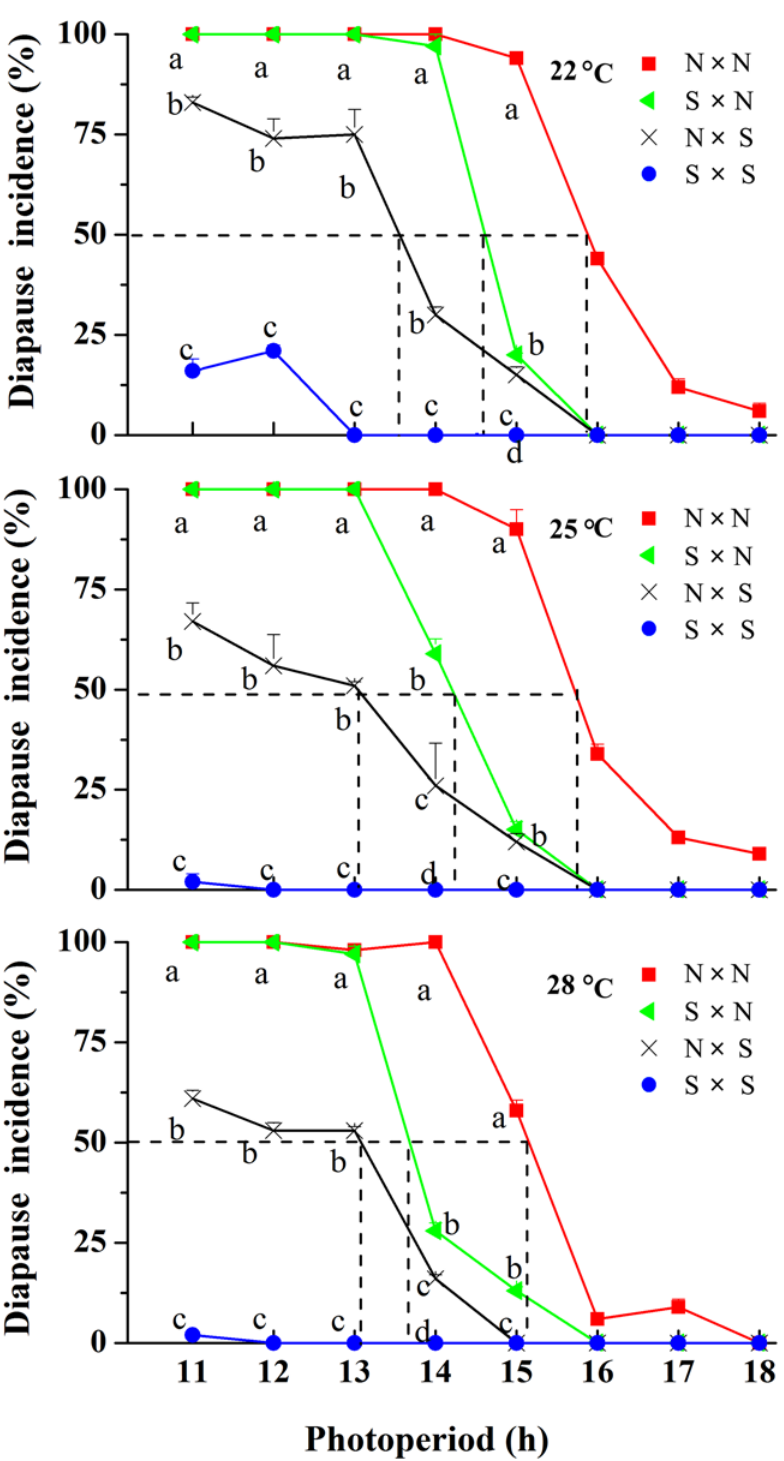
Fig 1. Photoperiodic response curves for the induction of larval diapause in Ostrinia furnacalis for the northernmost Harbin strain (N × N) (females shown on the left), the southernmost Ledong strain (S × S) and their F 1 progeny (N × S, S × N) at 22, 25 and 28°C (n = 56 – 336). Error bars indicate the SD. Bars with different lowercase letters at the same photoperiod indicate significant differences in diapause incidence after one-way analysis of variance ( P < 0. 05) (22°C, 11 h: F 3, 8 = 3651.09, P (cid:3) 0.001; 12 h: F 3, 8 =